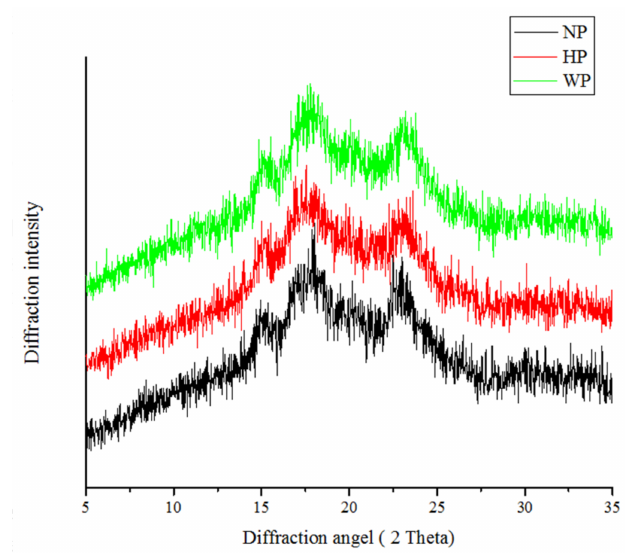
Figure 2. X-ray di ff raction patterns of djulis starch by the (1) hydrochloric acid isolation procedure (HP); (2) deionized water isolation procedure (WP); and (3) sodium hydroxide isolation procedure (NP) for djulis